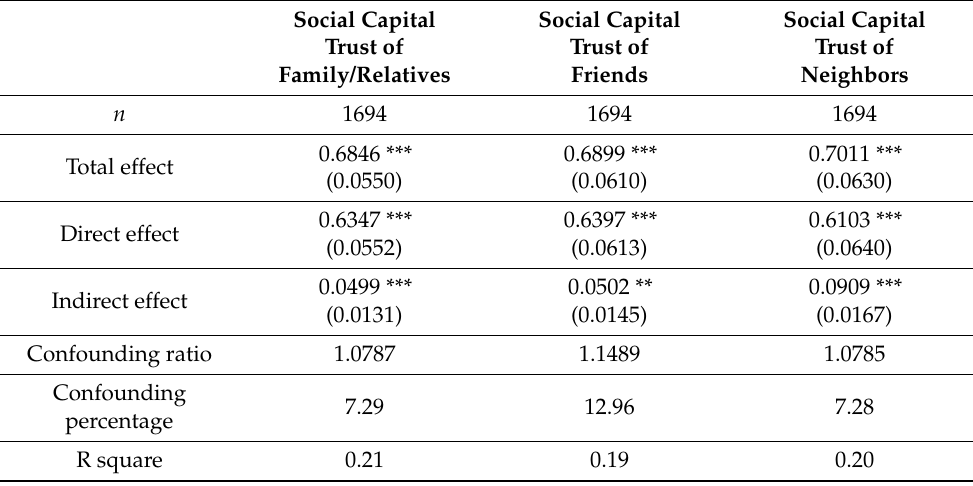
Table 5. Regression for effects for the association between social capital and life satisfaction, mediated by festival